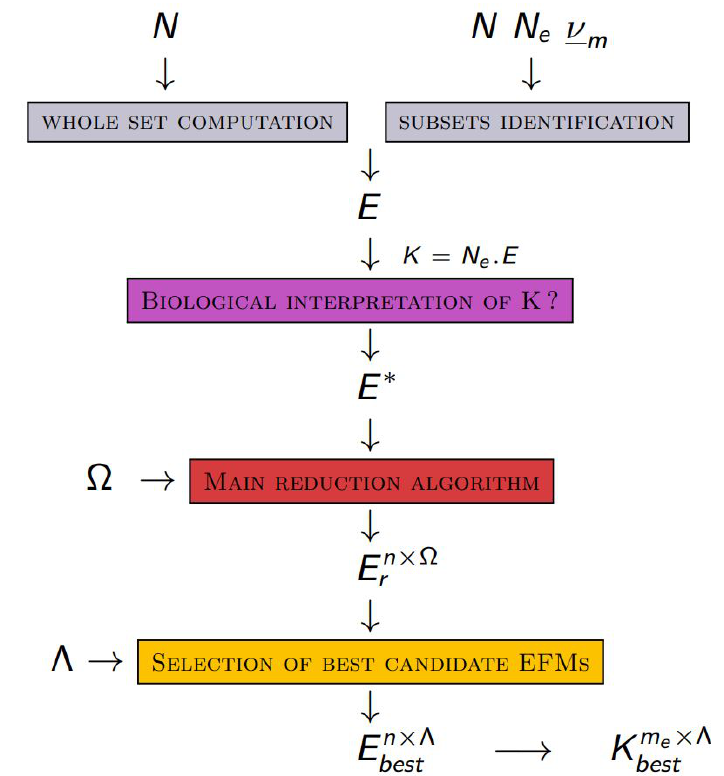
Figure 3. The modular EFM selection procedure. N is the stoichiometric matrix, N e is the stoichiometric matrix of extracellular measurements, ν m is the vector of experimental uptake and excretion rates, E is the matrix of EFMs and K describes the stoichiometry of the bioreactions. Ω is a first target number for the reduced set of EFMs, close to the number of measured extracellular species m e , and Λ is a second target number for the reduced set of EFMs, smaller than m e .